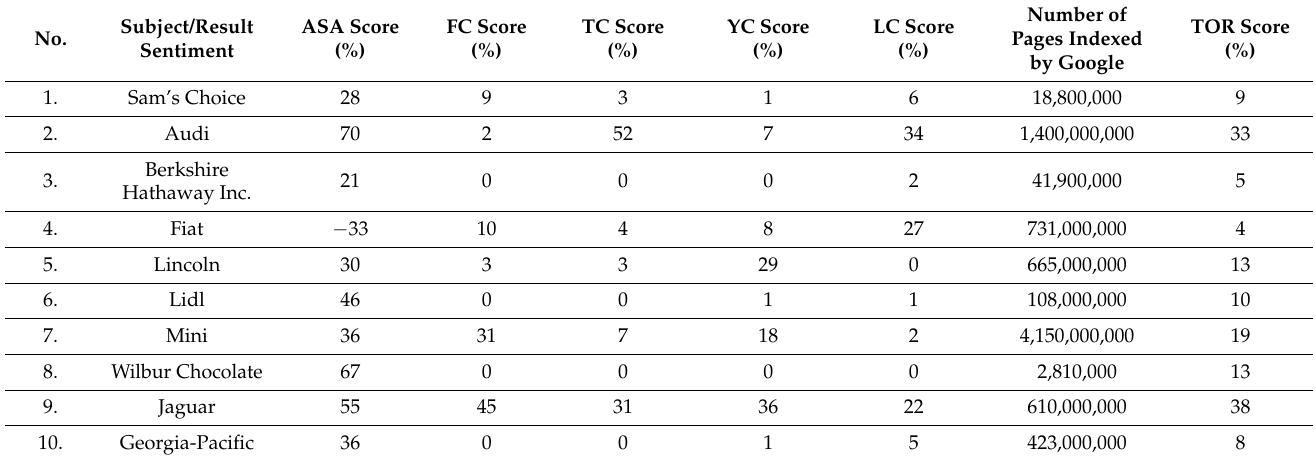
Table 3. Overall (Total) online reputation-